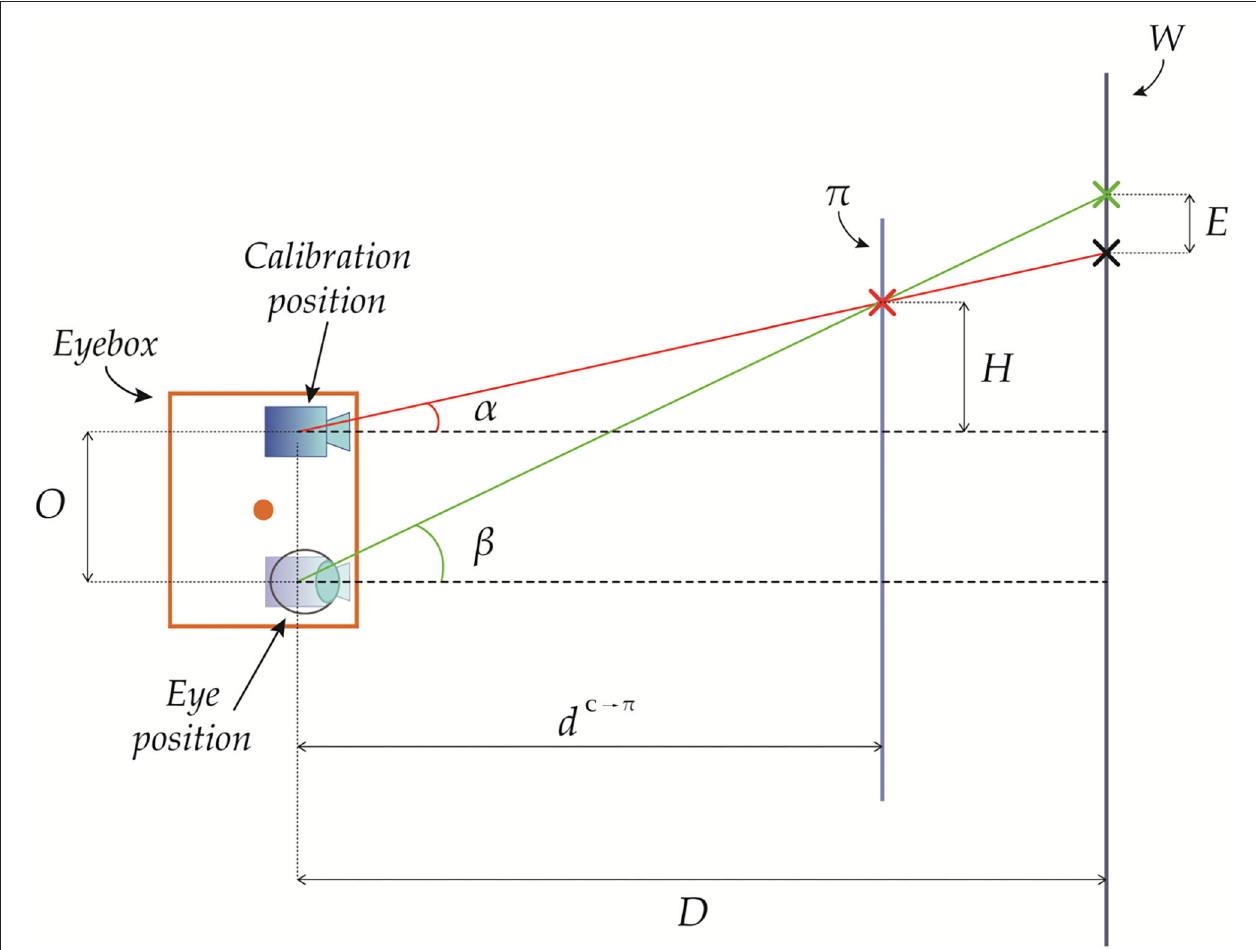
FIGURE 5 | Geometrical representation of the registration error due to a viewpoint shift between a viewpoint position and a calibration position at a depth p R C z > d C → π